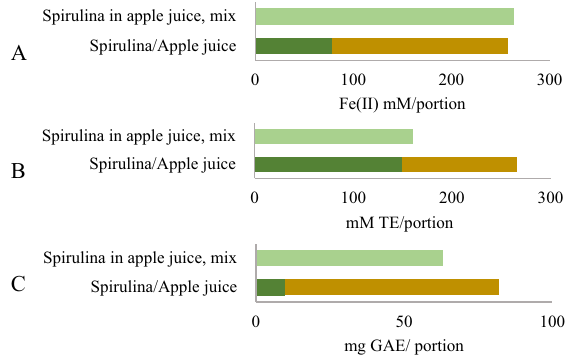
Figure 3. Reducing power ( A ), antioxidant activity ( B ) and polyphenol content ( C ) by portions (1st day). 7 g fresh spirulina, 14 g apple juice, and a mixture of